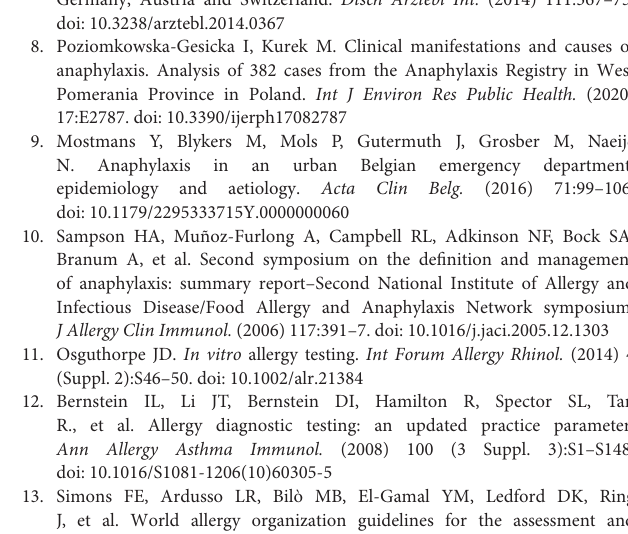
Supplementary Table 1 | Clinical characteristics of patients with anaphylaxis who underwent allergy tests ( n = 74) and a comparison of the severity of anaphylaxis (mild to moderate vs.